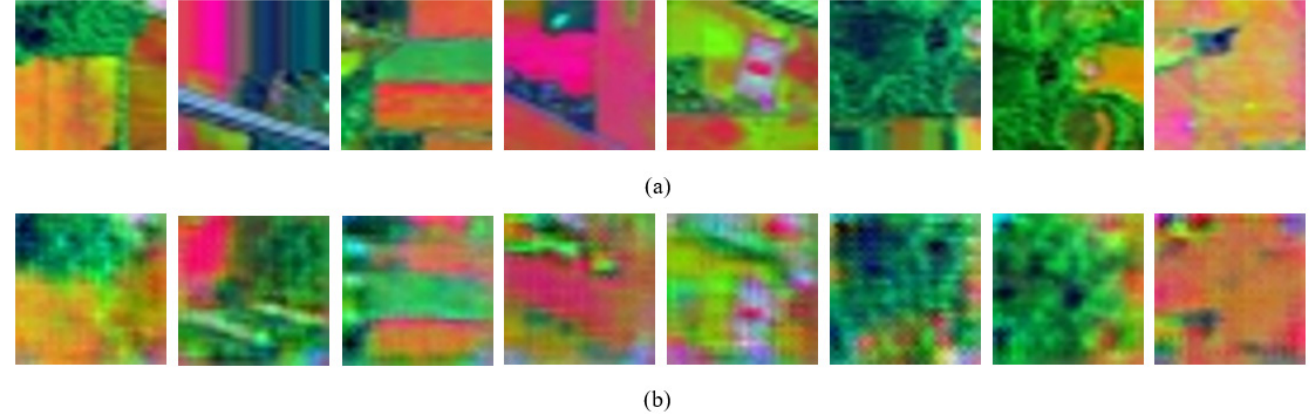
Figure 3. Visualization of the real image blocks ( a ) and the corresponding resulting image block ( b